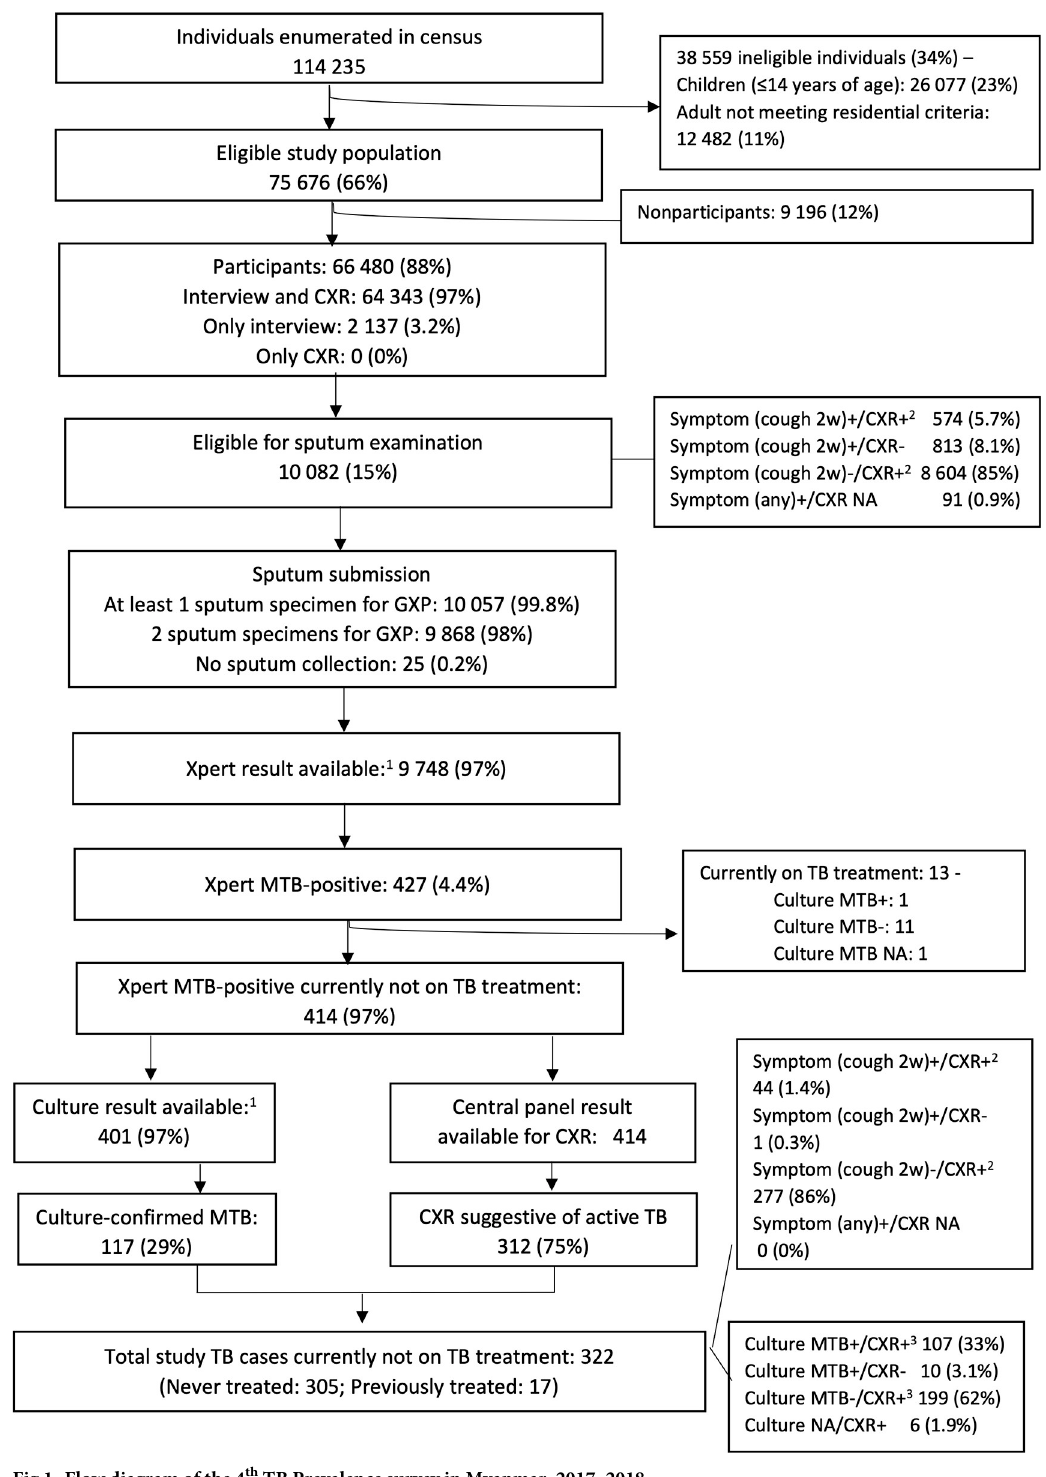
Fig 1. Flow diagram of the 4 th TB Prevalence survey in Myanmar, 2017–2018.